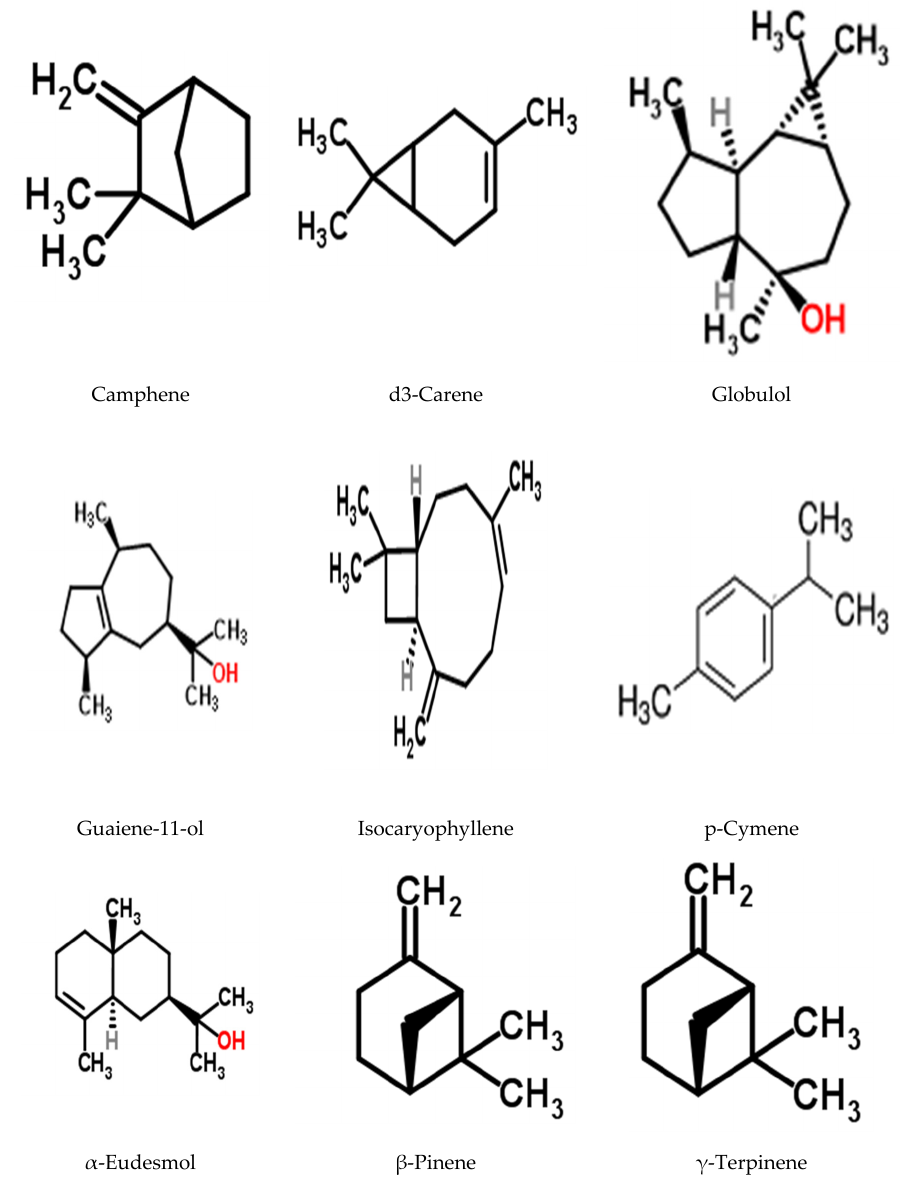
Figure 3. Some identified compounds from the root oil of S. jollyanum.